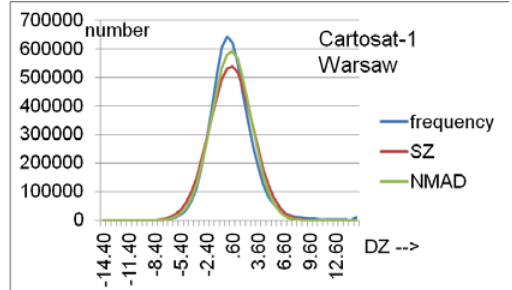
Figure 6. Frequency distribution of height differences, Cartosat-1 Warsaw